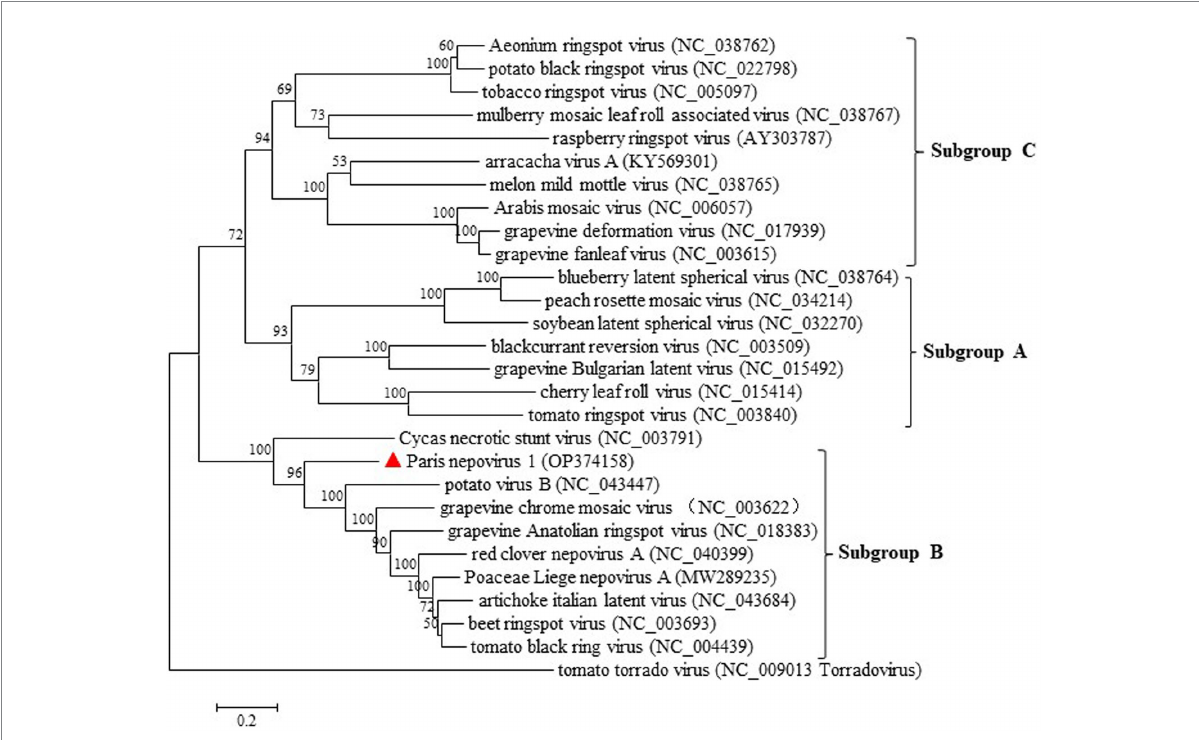
FIGURE. 5 Maximum-likelihood tree based on the deduced polyprotein of ParNV-1 as well as those of the representative members in different subgroup of genus Nepovirus . Bootstrap analysis was applied using 1,000 bootstrap replicates. The scale bar representing a genetic distance of 0.2. Tomato torrado virus, a member of genus Torradovirus , was used as an outgroup. Solid triangle indicated the ParNV-1 isolate characterized in this